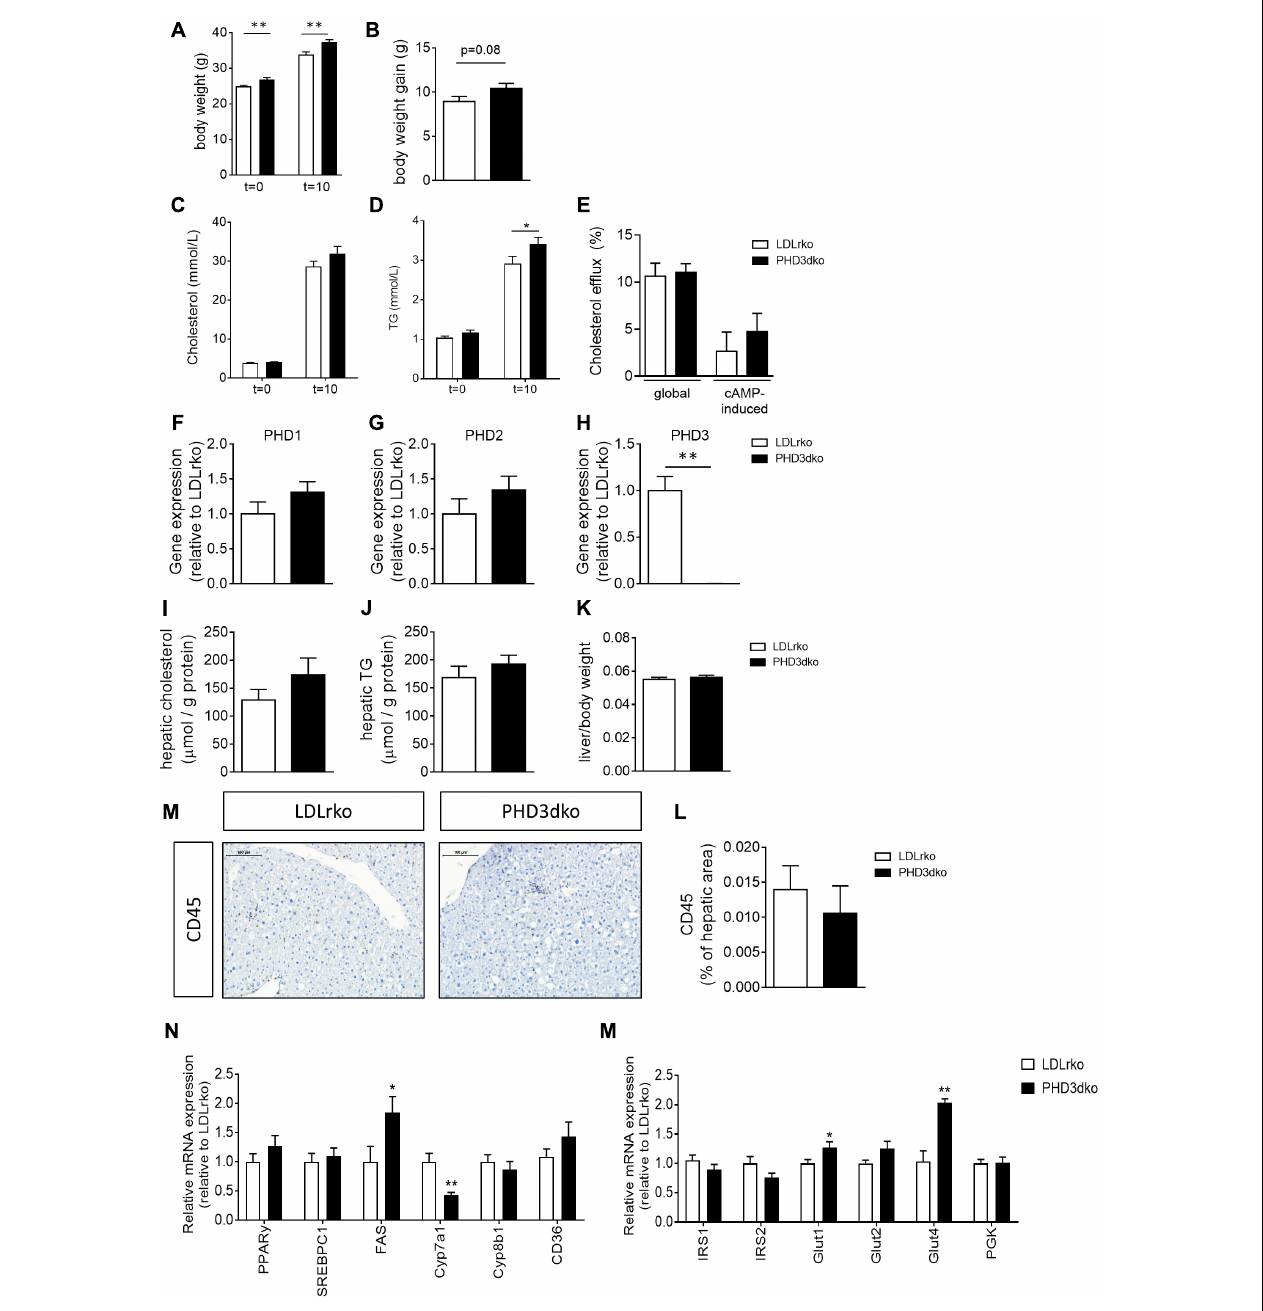
FIGURE 2 | PHD3dko mice showed increased bodyweight and circulating lipids. (A) Body weight of PHD3dko and LDLrko mice at start and end of the diet. (B) Body weight gain measured after 10 weeks of diet. (C,D) Plasma cholesterol and TG levels at start of diet and 10 weeks of diet. (E) Global and cAMP-induced cholesterol efflux capacity of LDLrko and PHD3dko BMDMs. (F) Gene expression of PHD1, (G) PHD2, and (H) PHD3 in whole liver tissue of LDLrko and PHD3dko mice ( n = 5/group). Expression is relative to LDLrko expression levels of respective gene of interest. (I,J) Hepatic cholesterol (PHD3dko n = 20, LDLrko n = 14) and TG (PHD3dko n = 20, LDLrko n = 13) content of mouse livers corrected for total amount of hepatic protein. (K) Liver weight corrected for total body weight. (L) Representative microphotographs of CD45 stained sections of liver. Scalebar represents 100 µ m. (M) Hepatic inflammation as measured by CD45 positive cells per visible hepatic area (PHD3dko n = 21, LDLrko n = 14). (N) Gene expression of lipid and glucose homeostasis related genes in livers of PHD3dko mice. Expression depicted relative to LDLrko expression levels of respective gene of interest (LDLrko N = 9, PHD3dko N = 7). PPAR γ , peroxisome proliferator-activated receptor gamma; SREBPc1, sterol regulatory element-binding protein; FAS, fatty acid synthase; CYP7a1/8b1, cytochrome P450 7a1/8b1; CD36, cluster of differentiation 36; Glut1/2/4, glucose transporter 1, 2, or 4; IRS1/2, insulin receptor substrate 1/2. Sample size n = 14 for PHD3dko and n = 22 for LDLrko groups unless otherwise stated. All results show mean ± SEM. * p < 0.05, ** p < 0.01.